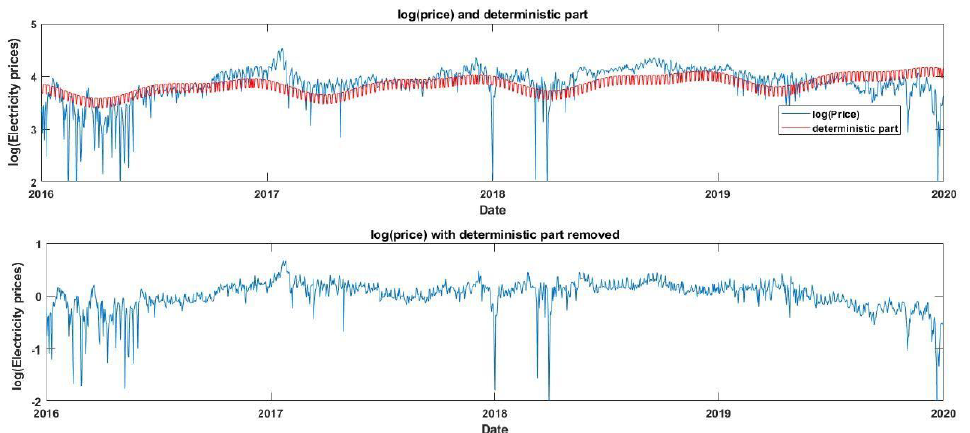
Figure 4. Daily natural logarithm of Spanish electricity prices from 2016 to 2019 with their determin- istic and stochastic parts.